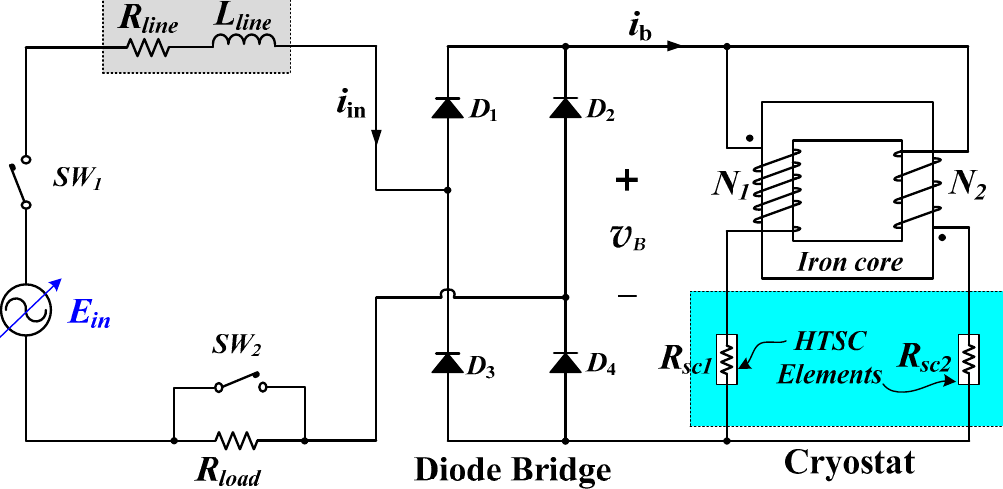
Figure 3. Schematic diagram for the experimental circuit of bridge type SFCL with simultaneous quench according to the input voltage variation.